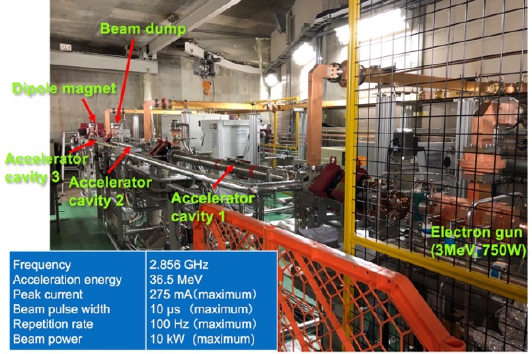
Fig. 4. Photo of the electron linear accelerator.